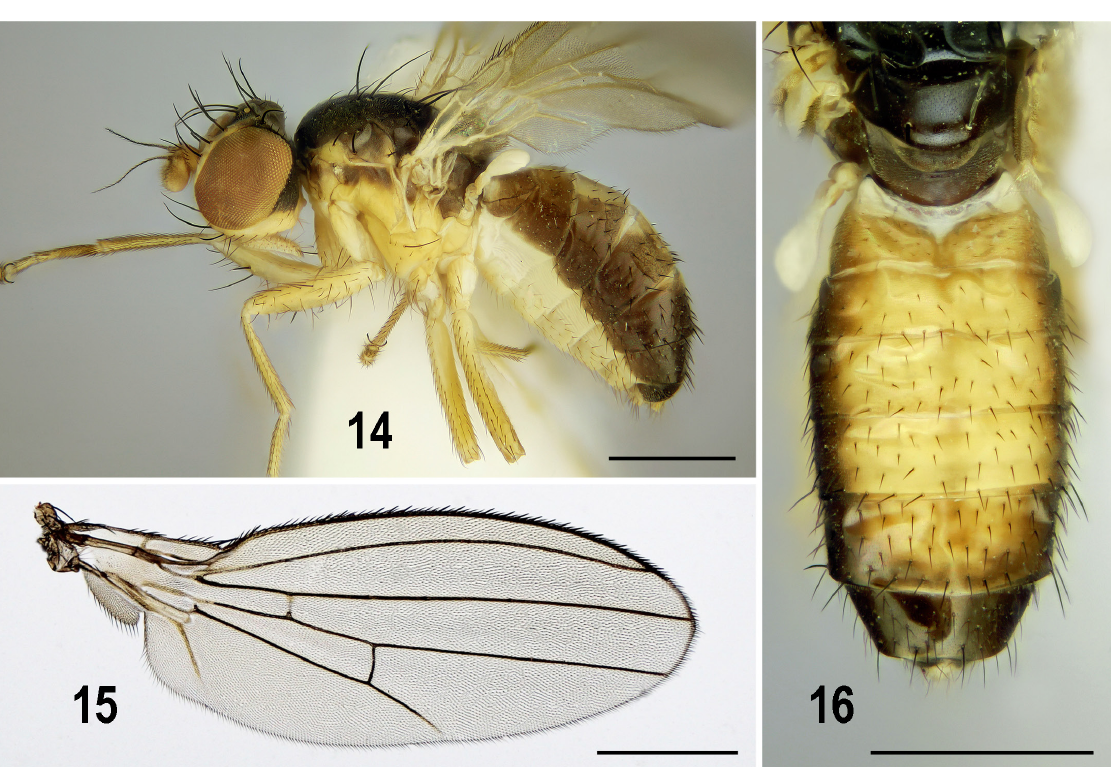
Figs 14–16. Mumetopia interfeles Roháček sp. nov., female paratypes (SMOC MIT076–MIT078). 14 . Body of aberrant specimen, lateral view. 15 . Right wing. 16 . Posterior part of thorax and abdomen, dorsal view. Scale bars = 0.5 mm. Photos by P.